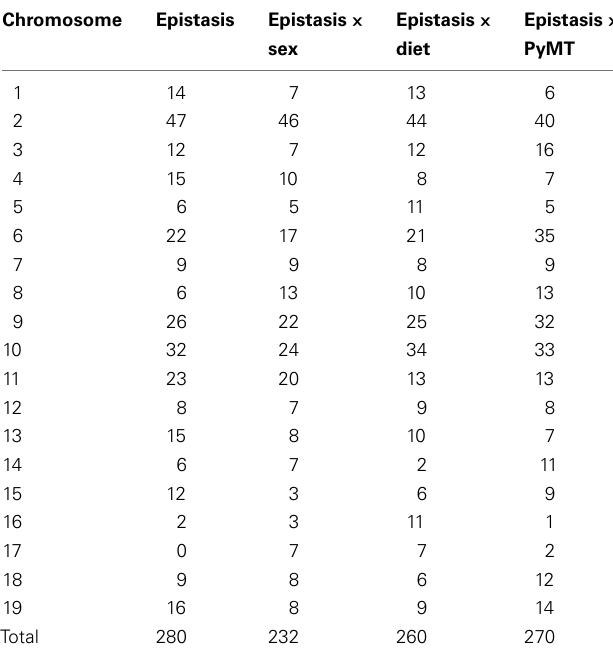
Table 3 | Numbers of epistasis and the epistatic interactions with sex, diet, and PyMT on each of the 19 chromosomes that significantly affected the weight and adiposity